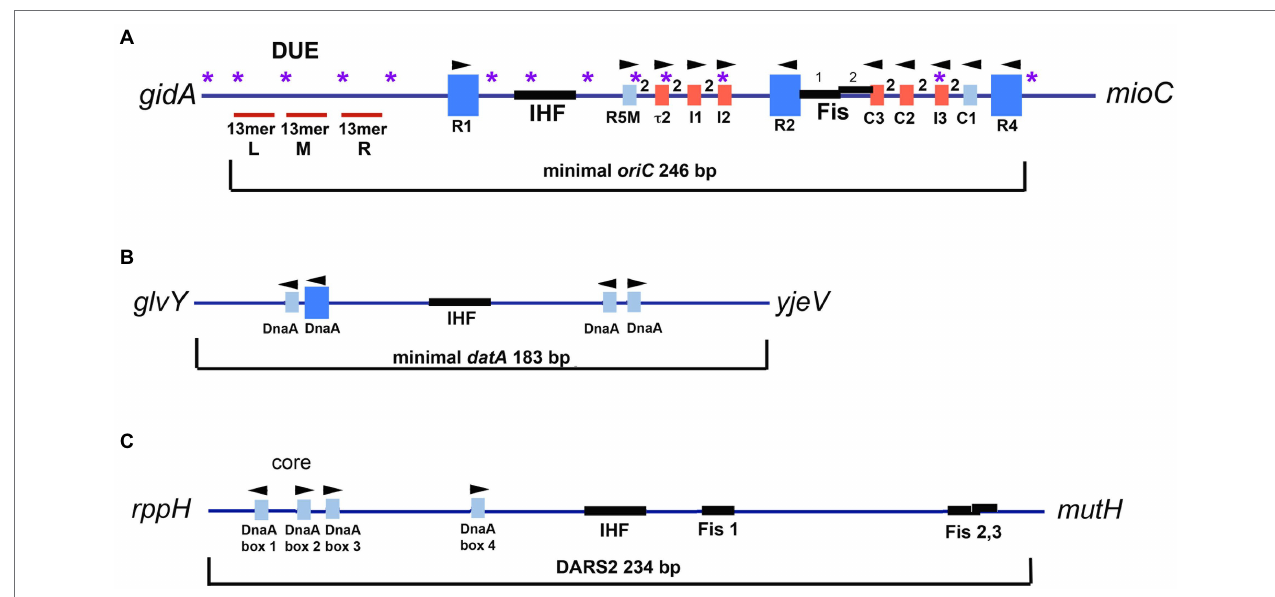
FIGURE 1 | (A) Map of E. coli oriC . The large blue rectangles are high affinity DnaA recognition sites. Smaller rectangles are low affinity DnaA recognition sites that deviate from the high affinity consensus by two or more bp and are shown in red for low affinity sites that preferentially bind DnaA-ATP, and blue for low affinity sites that bind both DnaA-ADP and DnaA-ATP. The number 2 between boxes indicates the 2 bp spacing between sites. The positions of the two binding sites for Fis, and the IHF binding region, are shown, as well as the left (L), middle (M), and right (R) 13mer repeats in the DNA unwinding element (DUE). Purple asterisks indicate the positions of 5 ′ -GATC motifs, which, when hemimethylated after oriC is replicated, bind SeqA. Arrowheads indicate the orientation of the R285 residue in bound DnaA. The figure is adapted from Leonard and Grimwade (2015). (B) Map of E. coli datA . High and low affinity DnaA recognition sites and the IHF binding site are marked. Although the affinity of the sites has not been examined, the sites deviate from consensus by at least one bp. (C) Map of E. coli DARS2 region. DnaA recognition sites and the IHF and Fis sites are